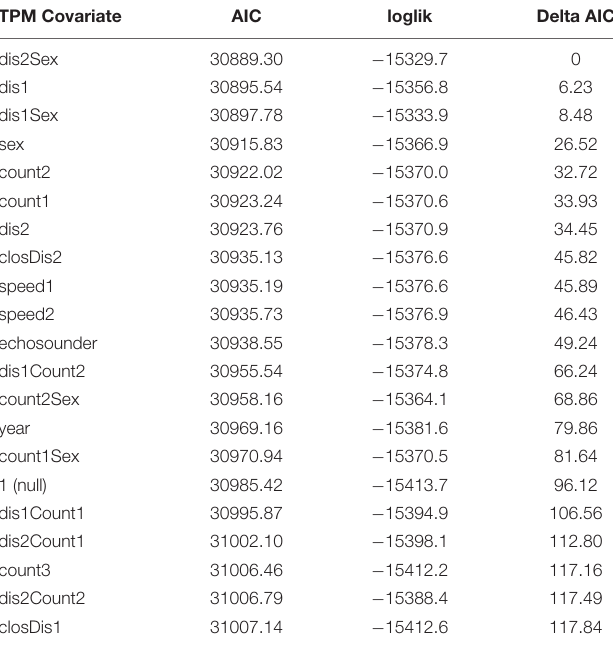
TABLE 5 | AIC, log-likelihood and delta AIC values for all 4-state